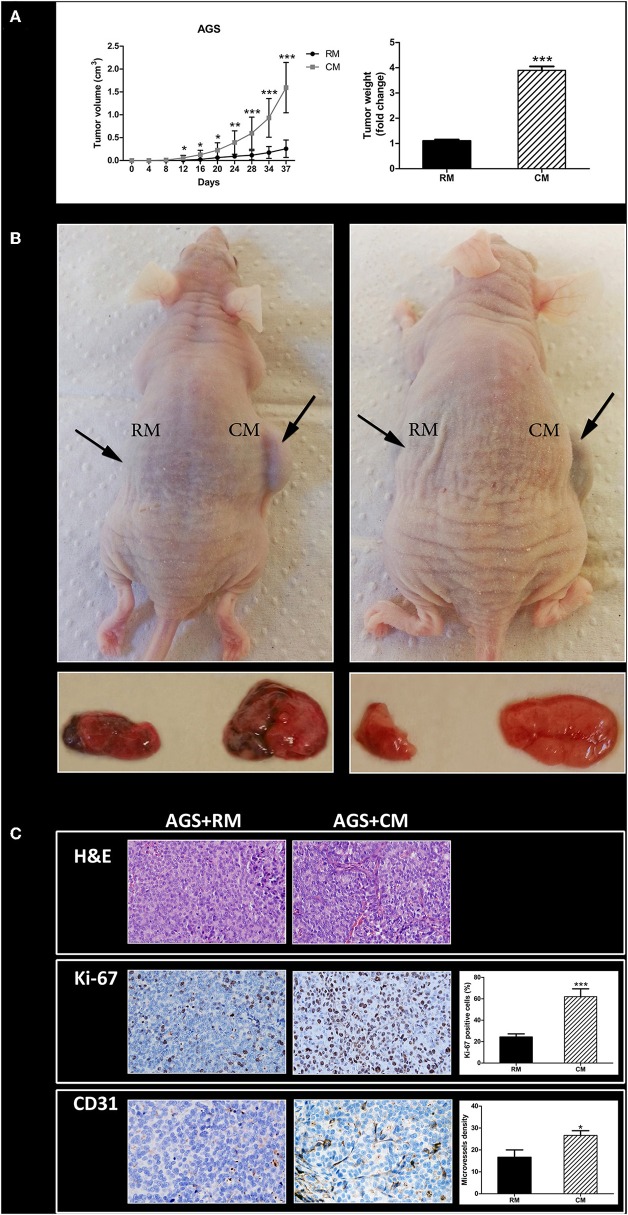
Omental tissue promotes tumor growth in vivo. (A) Growth and weight of AGS tumors was facilitated in mice after incubation with omental tissue CM (n = 15). Graphs represent the average of three repeated experiments ± SD (P < 0.005); (B) Images of representative tumor and mice; (C) Human omental tissue CM increase the proliferation (Ki-67) and microvessel density (CD31) of mice xenografts. Representative images are shown on the left (H&E, ×200; Ki-67, ×200; CD31, ×200). Immunohistochemistry (IHC) quantification is shown on the right. n = 10 in tissues of each site. *P < 0.05; **P < 0.01; ***P < 0.001.